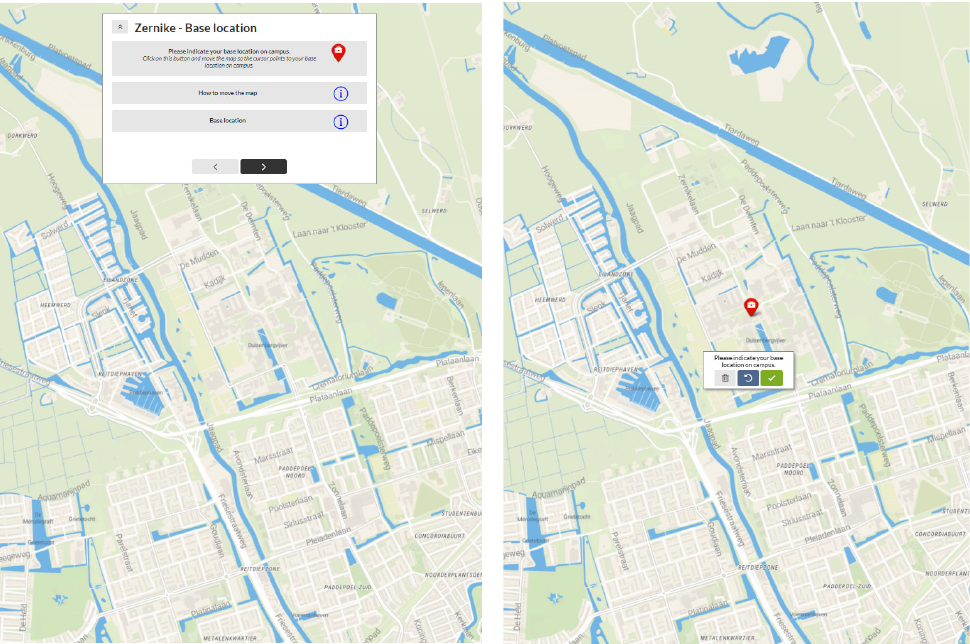
Figure A1. RUG campus—Maptionnaire screenshot: indicating base location.